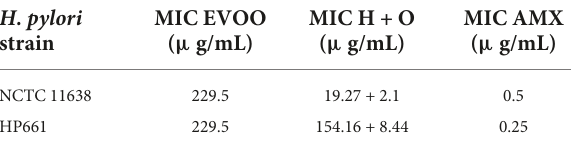
TABLE 1 Minimal inhibitory concentration (MIC) of the extra virgin olive oil (EVOO) and the combined effect of hydroxytyrosol (HT) and oleuropein